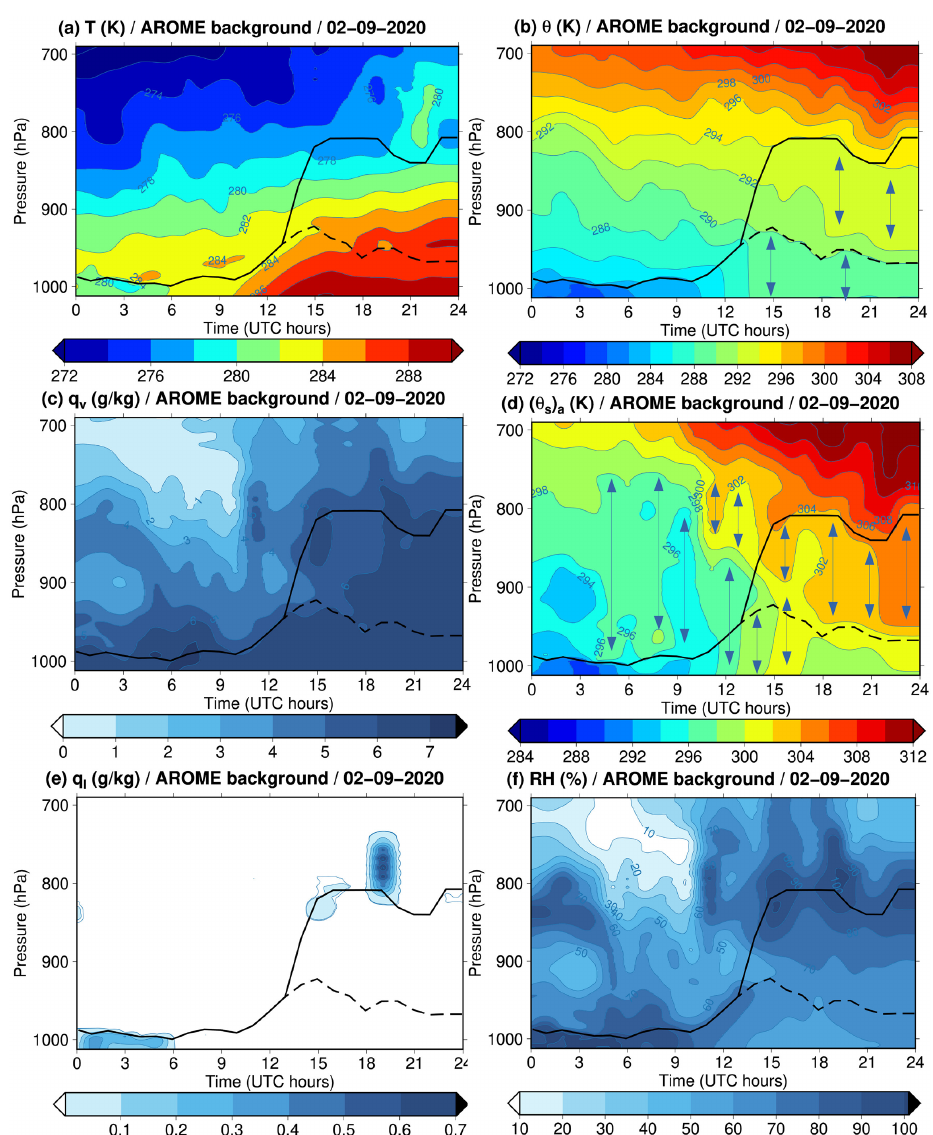
Figure 2. Vertical profiles derived from 1h forecasts of AROME background for all hours of the day 9 February 2020 at Saint-Symphorien (Les Landes region in France) for (a) absolute temperature T every 2K, (b) dry-air potential temperature θ every 0 . 2K, (c) water-vapour specific content q v every 1gkg − 1 , (d) entropy potential temperature (θ s ) a every 0 . 2K, (e) cloud liquid-water specific content q l (contoured for 0 . 00001 and 0 . 002gkg − 1 , then every 0 . 1gkg − 1 above 0 . 1gkg − 1 ) and (f) relative humidity (RH) every 10%. The black curves (solid and dashed lines) represent the planetary boundary layer (PBL) heights determined from the maximum of the vertical gradients of θ . The vertical arrows in (b) and (d) indicate areas where potential temperatures are almost homogeneous or constant along the vertical.